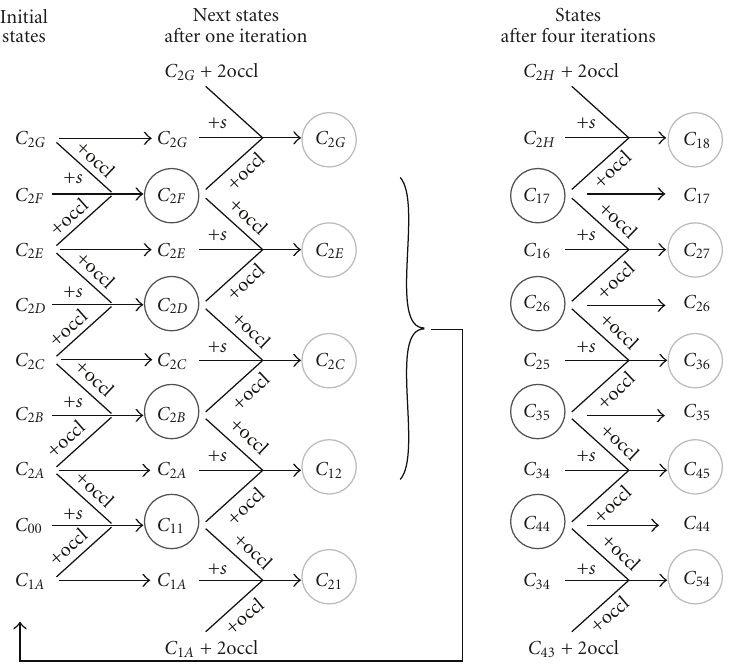
Figure 8: Initial state and successive derivation of next states with a nine-state processing element.